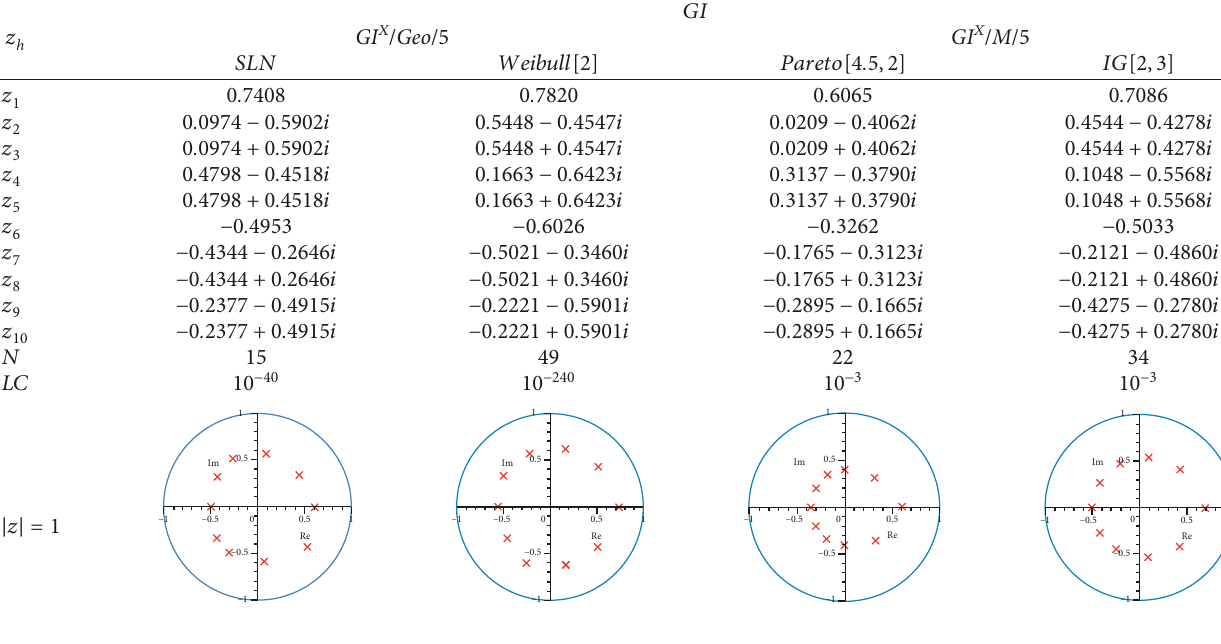
� 0 . 9 , b � 0 . 1, and ρ � 0 . 25. 1 10